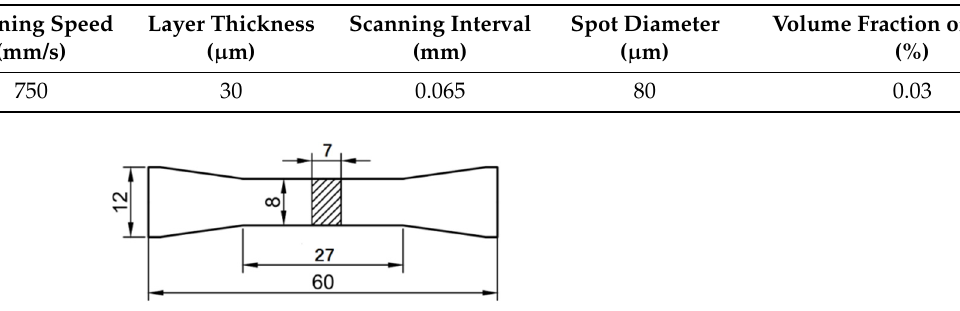
Table 2. Main processing parameters.